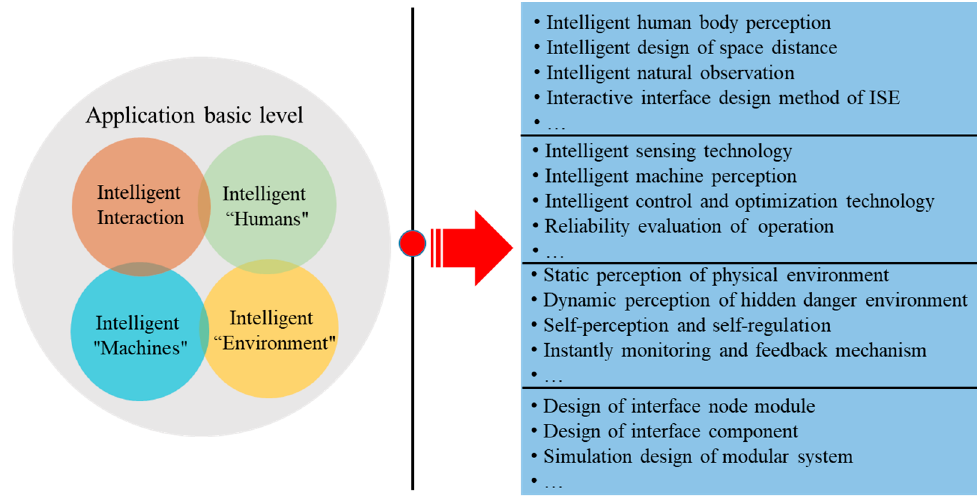
Figure 6. Basic application level of ISE. Application of the basic level mainly includes intelligent interaction, intelligent humans, intelligent machines, and the intelligent